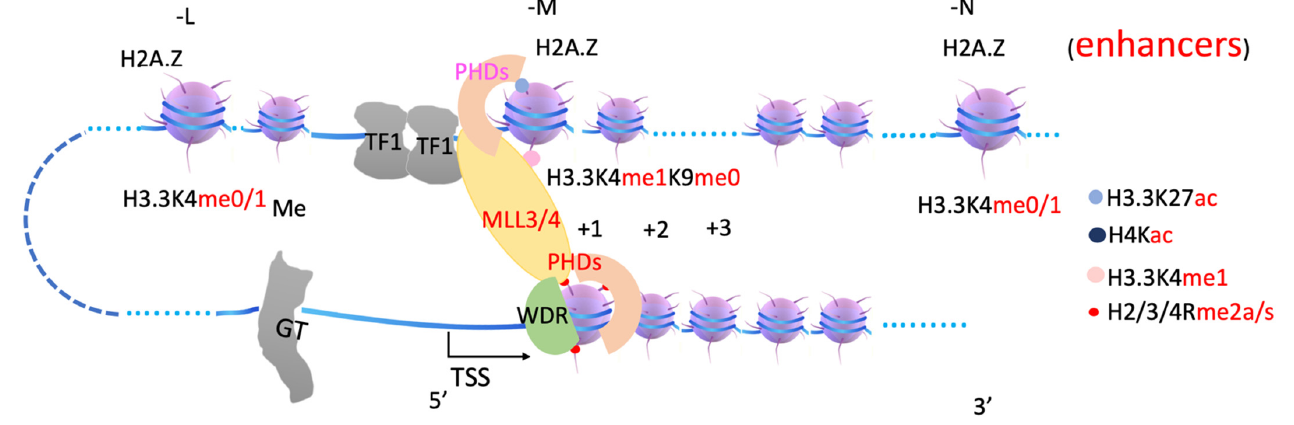
Figure 4. A model of how MLL3/4 is recruited by arginine methylated histones on +1 nucleosome. MLL3/4 complex is recruited by arginine methylated histone tails at +1 nucleosome through PHD domains and/or WDR domain-containing proteins, is responsible for generating H3.3K4me1 at enhancers. MLL3/4, Myeloid/Lymphoid or Mixed-Lineage Leukemia Protein 3/4. WDR, WD repeating-containing protein.